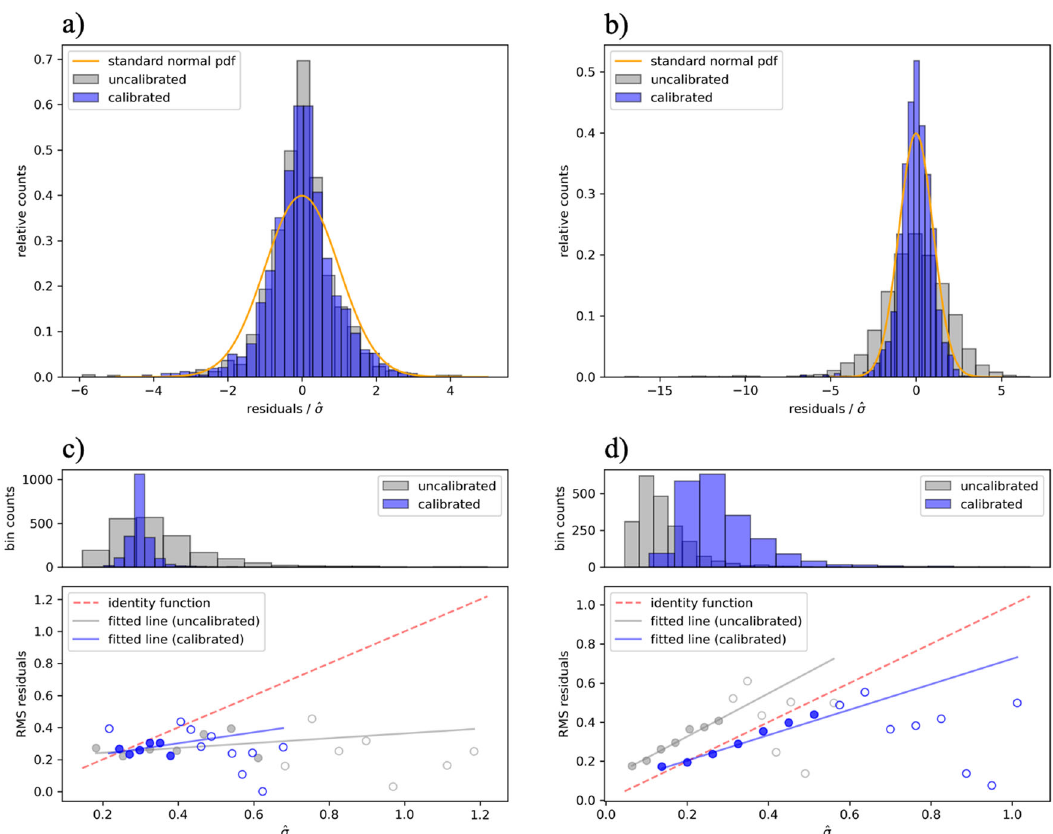
Fig. 3 Bayesian vs. bootstrap calibrated and uncalibrated r-statistic and RvE plots for a single GPR model. Distributions of r-statistic values (top row) and RMS residual vs. ^ σ GPR plot (bottom row) for Bayesian uncertainty estimates obtained from a single Gaussian process regression model (panels a and c ) and bootstrap uncertainty estimates obtained for the same single Gaussian process regression model (panels b and d ), using the diffusion dataset. Both uncalibrated and calibrated ^ σ GPR values are shown. Markers which are not fi lled in represent bins with fewer than 30 points. Statistics for each plot are summarized in Table